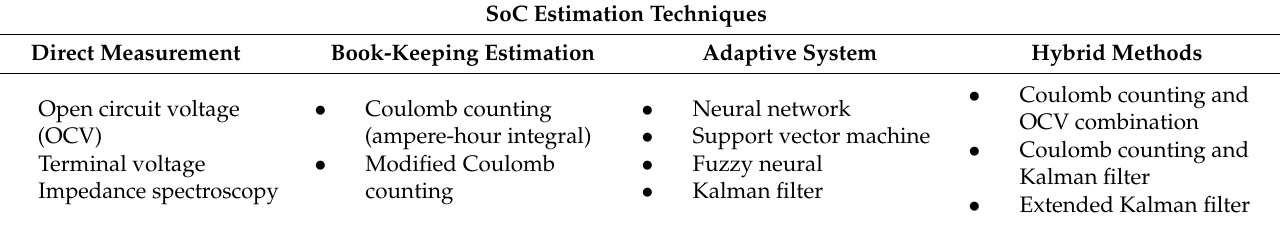
Table 4. SOC estimation techniques.